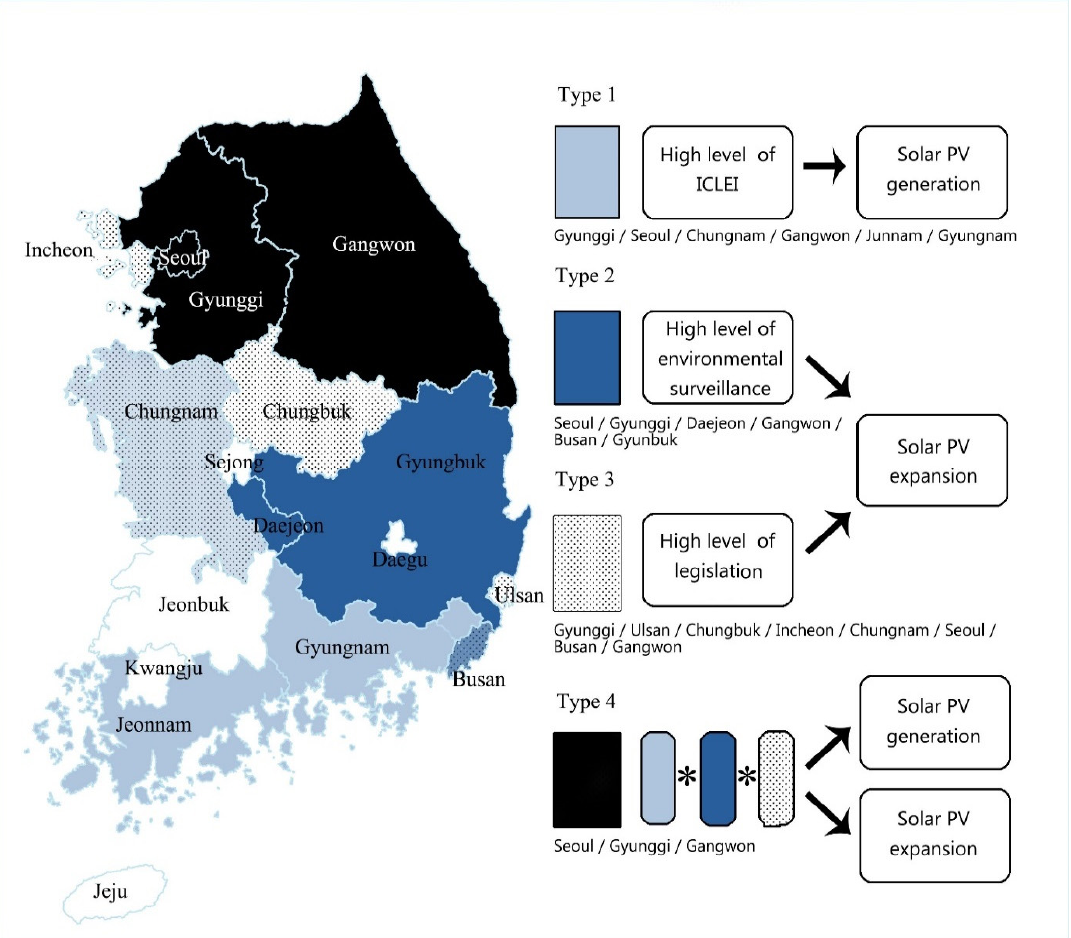
Figure 2. Pathways to a successful local energy transition.